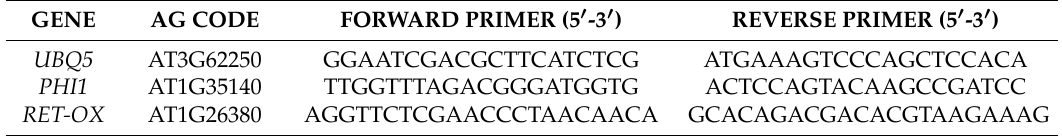
Table 1. Primers used in this